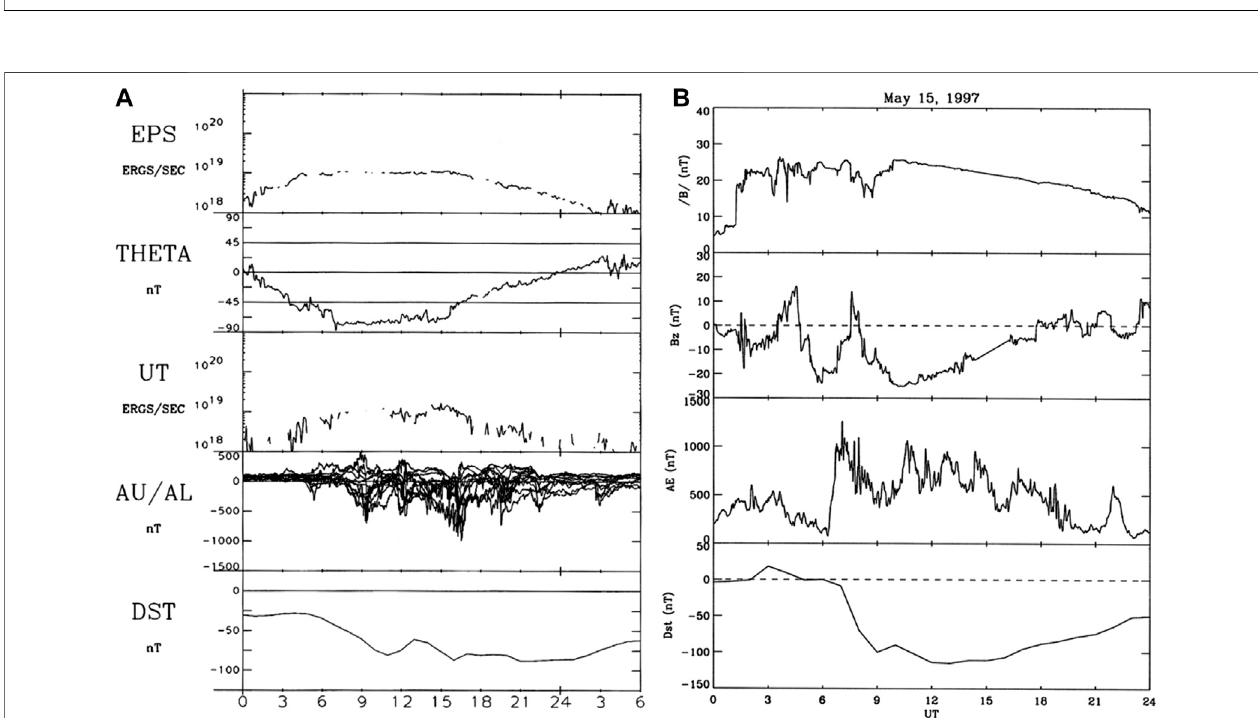
FIGURE 16 | Geomagnetic storms and substorms when the power of the dynamo is continuously high. (A) A high power was kept continuously for more than 10 hours. (B) High power is a smoothly decreasing case.